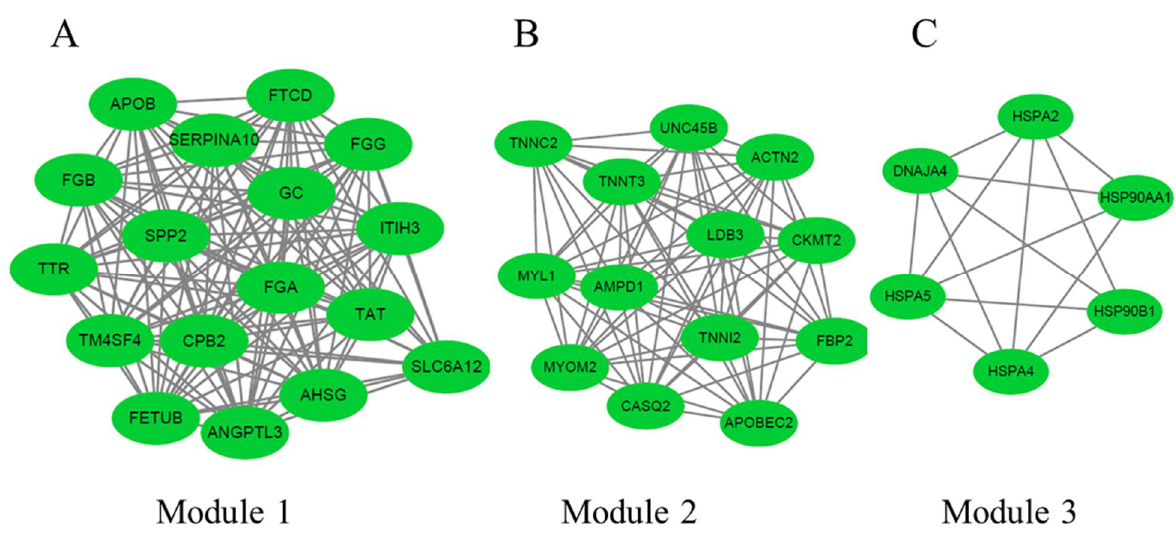
Figure 7. The three protein–protein interaction (PPI) hub network modules were constructed from the PPI network of DEGs between 66 and 35 weeks using MCODE. ( A ) Module 1 (MCODE score = 16.5), ( B ) module 2 (MCODE score = 12.7), and ( C ) module 3 (MCODE score = 5.6). The green node represents the downregulated DEGs.